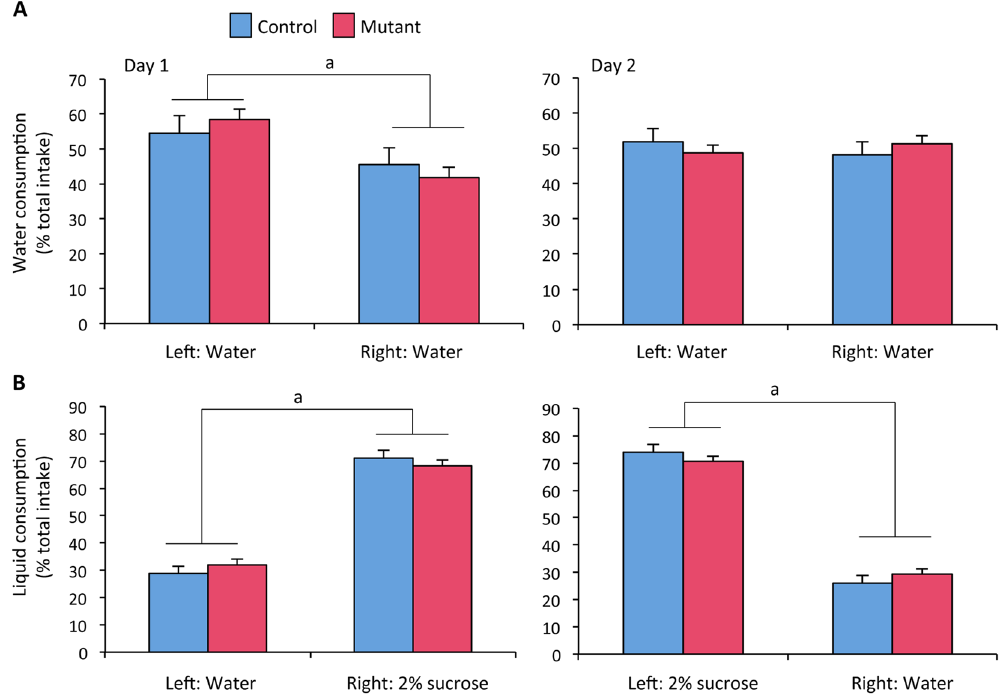
Figure 3. Effects of neural ER β knockout on sucrose preference in male mice. Control and mutant males (n = 11 per genotype) were subjected to sucrose preference test with the habituation phase ( A ) and testing sessions ( B ). ( A ) Water consumption over two consecutive days 1 and 2. Two-way ANOVA shows an effect of location ( a p < 0. 05) at day 1 but not at day 2. ( B ) Liquid consumption with the bottle containing 2% sucrose either at the right or left position. Two-way ANOVA shows an effect of solution for the two tests ( a p < 0.001), with a preference of sucrose regardless of the